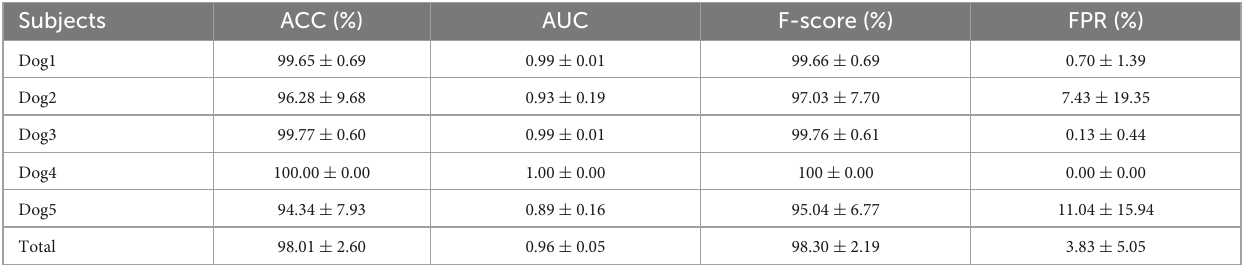
TABLE 4 Performance evaluation of our proposed method on the Kaggle dataset.